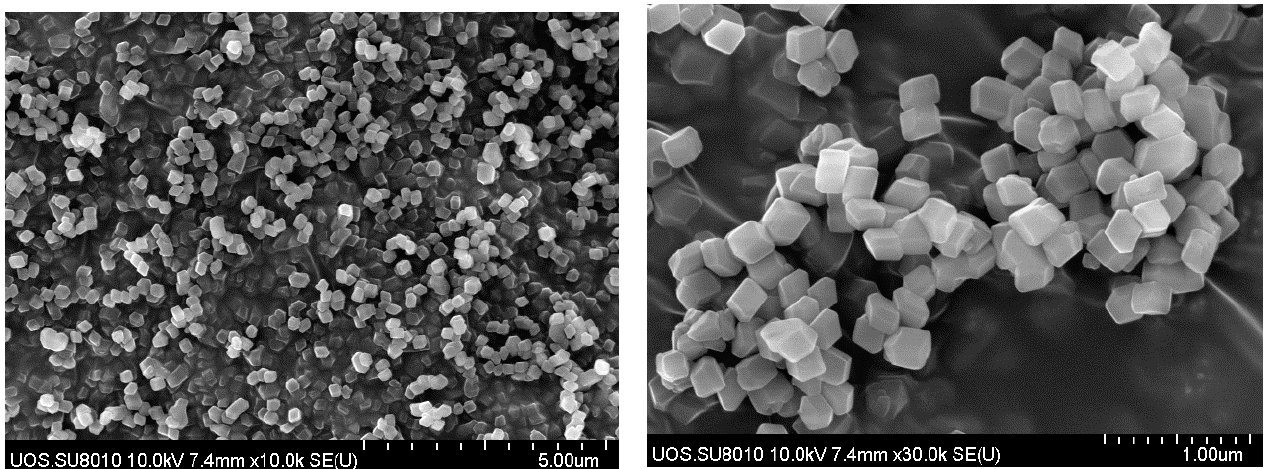
Figure 4. FE ‐ SEM images of synthesized ZIF ‐ 7.